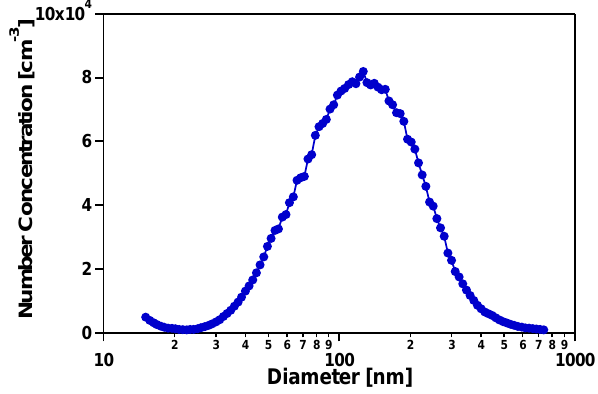
Fig. 3. Change with spraying time of the total number concentration Figure 3. Change with spraying time of the total number concentration (blue, left axis) and the (blue, left axis) and the mean size (red, right axis) of dry aerosols mean size (red, right axis) of dry aerosols generated by atomizing Ca(HCO 3 ) 2 solution. generated by atomizing Ca(HCO 3 ) 2